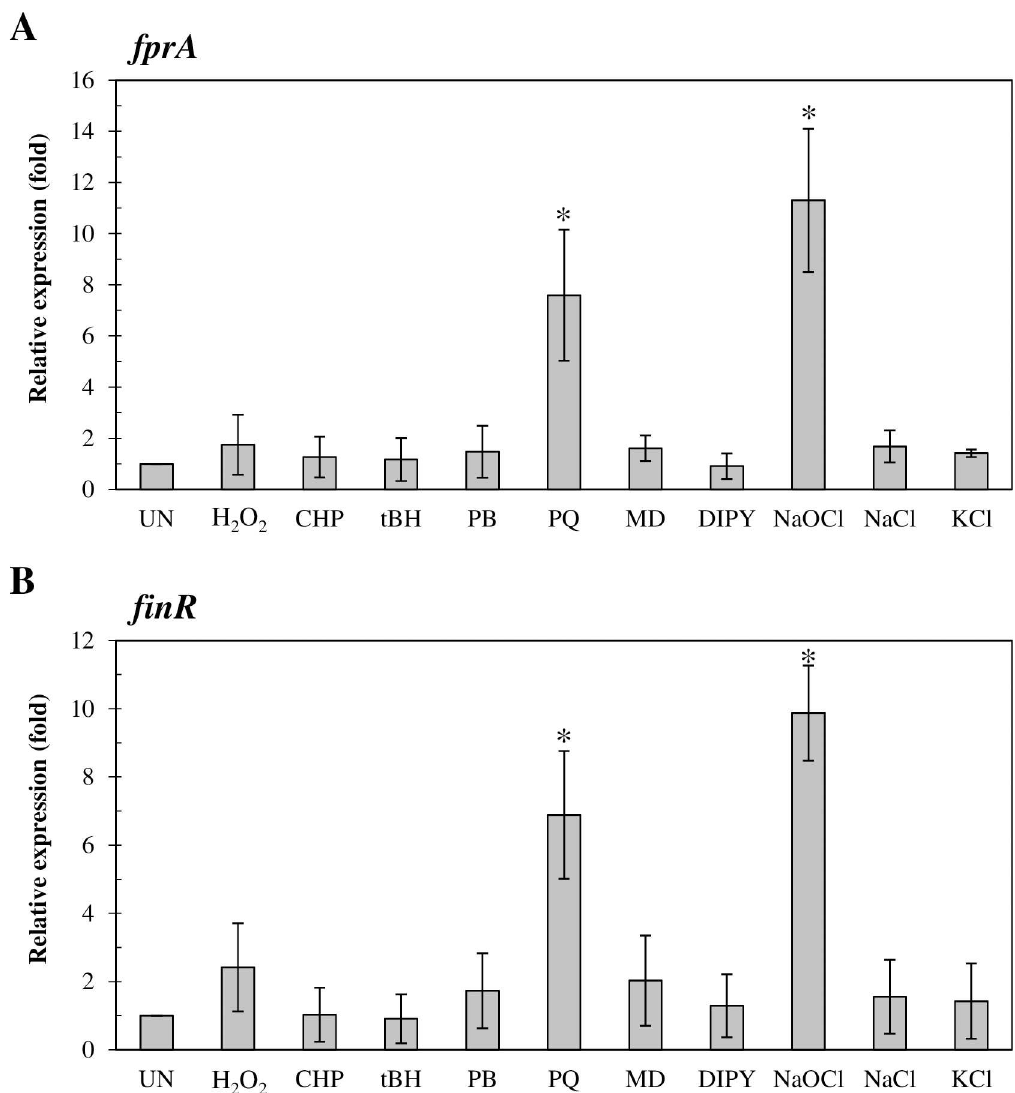
Fig 2. Expression analysis finR and fprA in response to various stresses. The expression levelsof finR (A) and fprA (B) weredetermined usingreal-timeRT-PCR. Exponential-phasecultures of P . aeruginosa PAO1 were subjected to various stress conditions,including 1 mM H 2 O 2 , superoxideanion-generating agents(0.5 mM plumbagin [PB], 0.5 mM menadione [MD] and 0.5 paraquat[PQ]), organichydroperoxides (1 mM cumenehydroperoxide [CHP] and 1 mM t -butylhydroperoxide [tBH]), 1 mM 2,2’-dipyridyl (DIPY), high salts (0.5 M NaCl and 0.5 M KCl), or 0.04% NaOCl for 15 minutesprior to RNA preparation for real-time RT-PCR analysis.Relativeexpressionwas analyzedusingthe 16S rRNA geneas the normalizing geneand was expressedas the fold expression relativeto the level of uninduced (UN) PAO1. Data shownare means ± SD of three independent experiments.